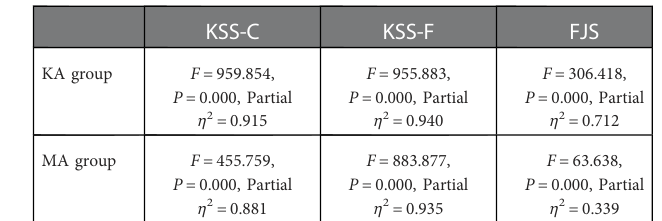
TABLE 3 The statistical results of the simple effect test of groups between KA and MA.